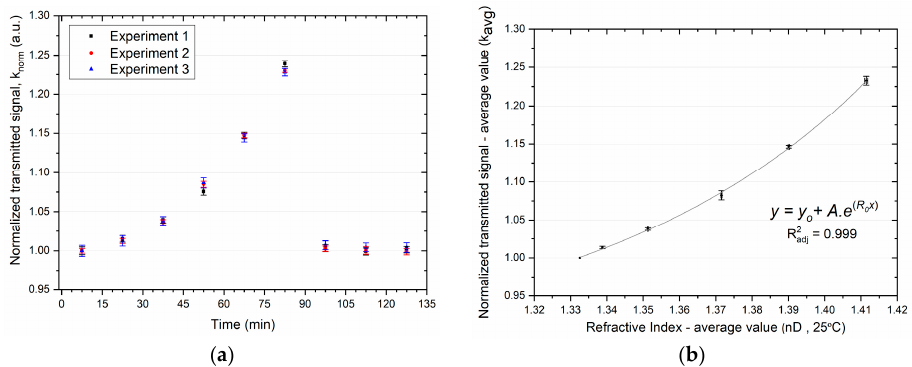
Figure 7. Response of the D-shaped POF sensor D2 when in contact with solutions of different refractive indices after Polishing 2 (P600): ( a ) normalized transmitted signal ( k norm ± δ k norm ) over time; ( b ) average value of the three replicated measurements ( k avg ± δ k avg ) and exponential fit.